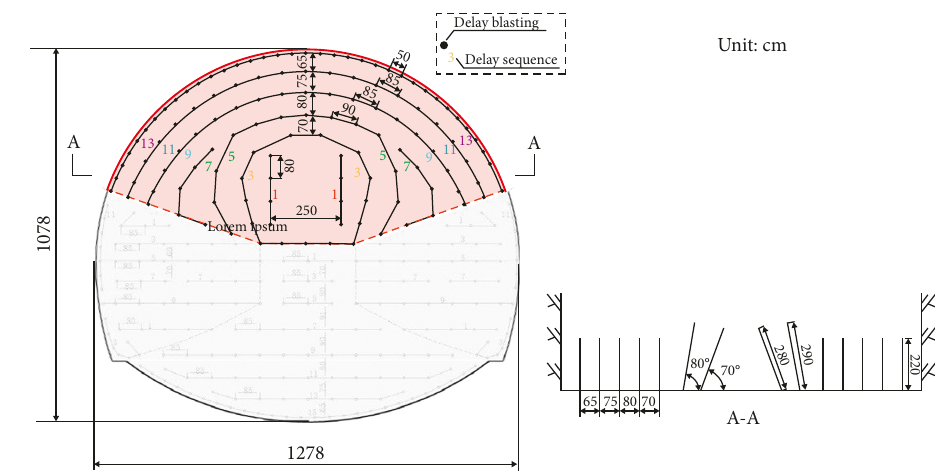
Figure 3: Blasting experiment